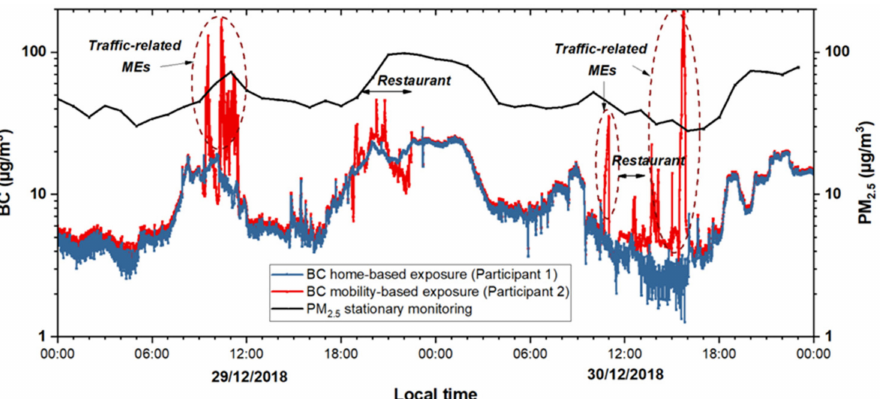
Figure 2. Time series of personal exposure to BC over 48 h for the home-based participant 1 (blue), and participant 2 during mobility-based exposure (red) and stationary PM 2.5 (black) values.